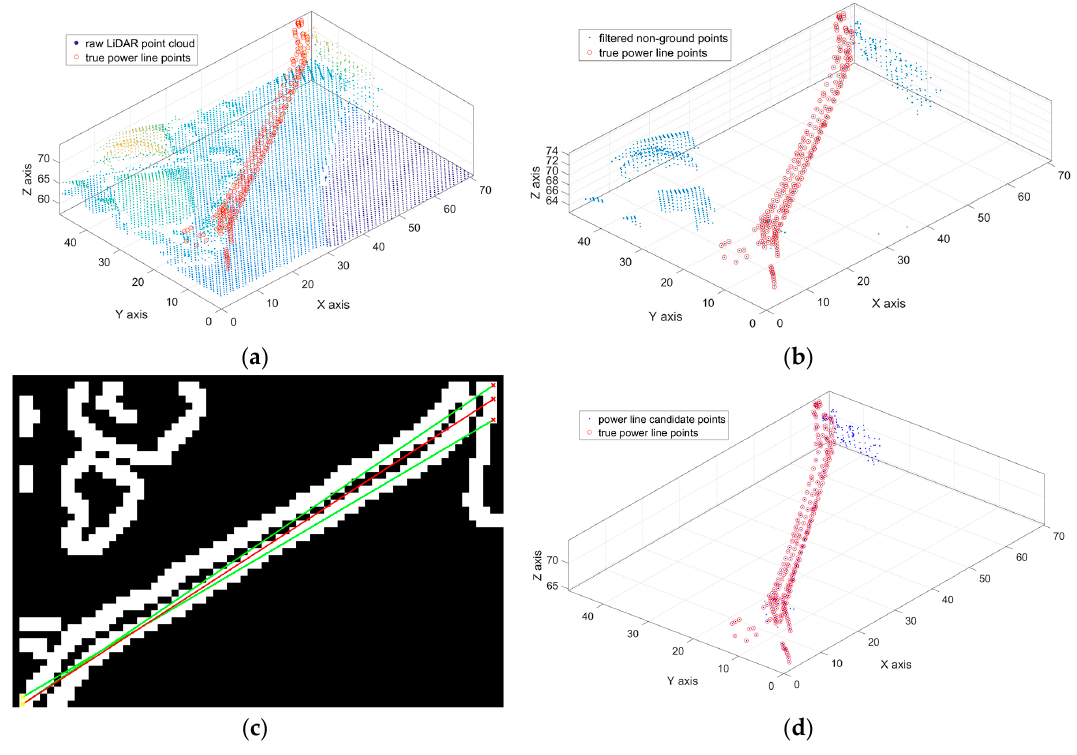
Figure 3. Visualization of power line candidate filtering process. ( a ) raw LiDAR point cloud; ( b ) non-ground points; ( c ) the detected power line 2D corridor direction in XOY plane: the green lines are extracted by Hough transform and the red line is the power line corridor direction constructed by RANSAC algorithm; ( d ) power line candidate points filtered by power line corridor direction: the red points are true power line points, the blue ones are the power line candidate filtering results.